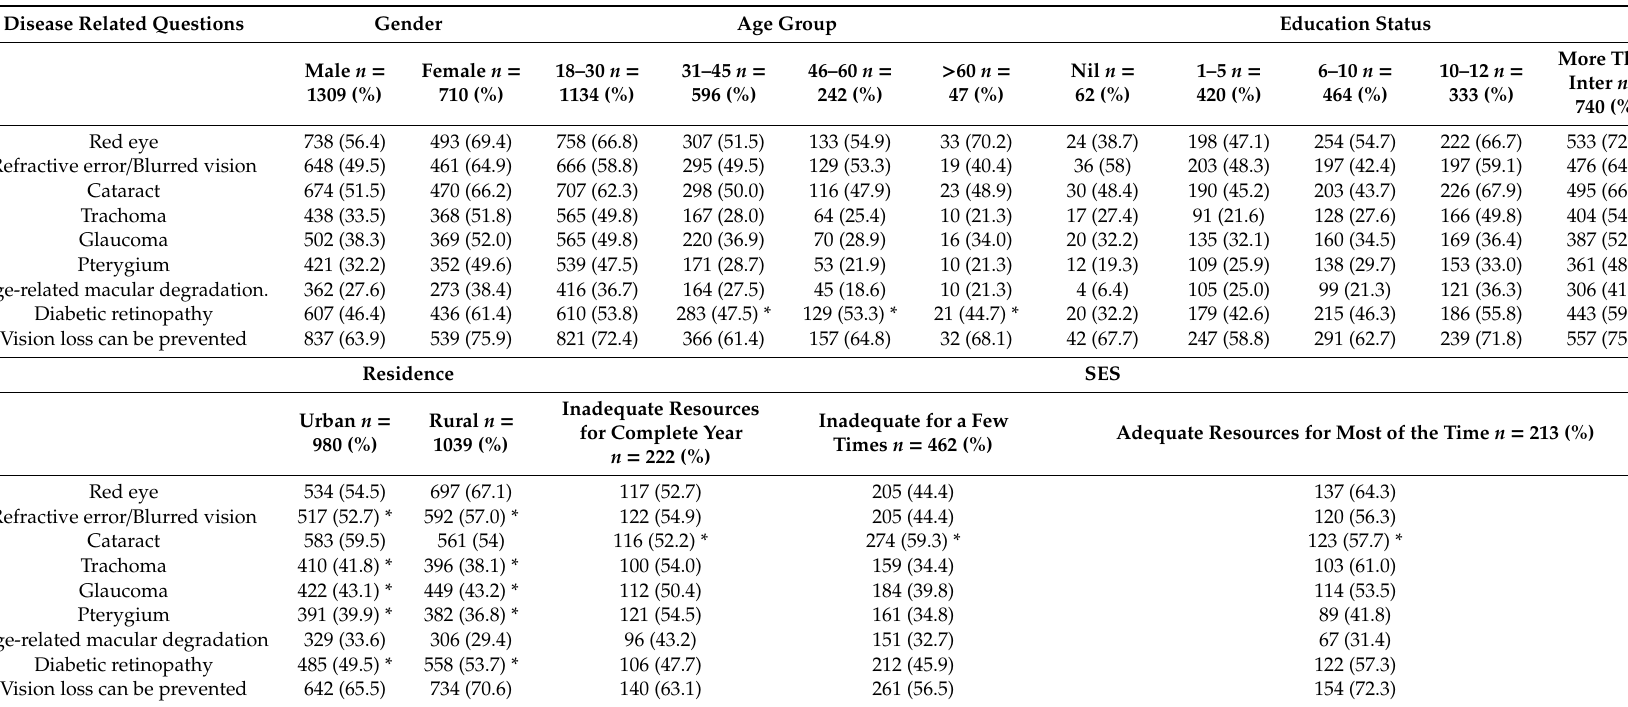
Table 2. Knowledge related items in terms of gender, age, education, locality and